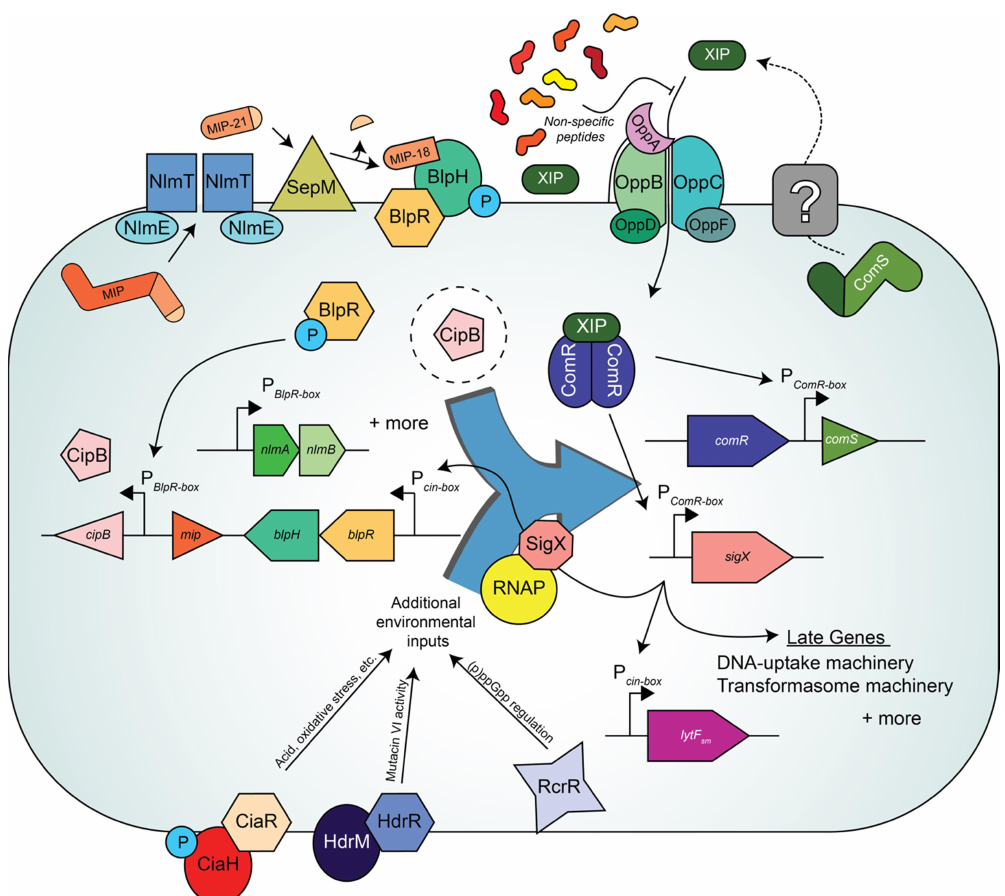
Figure 2. The ComRS quorum sensing (QS) pathway controls competence, and the BlpRH QS system regulates bacteriocin production in S. mutans strain UA159. The ComS pre-peptide is exported and processed via an unknown mechanism (denoted as a dotted line and gray box) into XIP. In a chemically defined, peptide-poor medium (CDM) XIP is re-imported via oligopeptide permease (Opp) and binds ComR. The ComR/XIP complex binds upstream of comS and sigX at P ComR -box sites [31]. The alternative sigma factor, SigX, facilitates RNA polymerase (RNAP) binding at P cin-box sites [64]. Genes regulated by SigX include the DNA-uptake and transformasome machinery as well as the murein hydrolase, LytF sm , among others [59,68]. Non-specific peptides present in high concentrations in peptide-rich media are thought to prevent intracellular transport of XIP via Opp [69]. Recently, a link between the bacteriocin and competence pathways was determined to be mediated by SigX at a P cin-box site upstream of blpRH (formerly referred to as comDE , see Table 1). The BlpRH QS pathway pheromone, MIP, is exported and processed by the ABC transporter complex NlmTE into the 21 amino-acid long precursor peptide, MIP-21 [27]. Cleavage of MIP-21 by the protease SepM results in fully active MIP-18 [11]. MIP-18 is thought to bind to BlpH, resulting in activation and phosphorylation of BlpR similarly to CSP binding and activation of ComDE in S. pneumoniae [13]. BlpR~P binds at P BlpR-box sites upstream of bacteriocin loci such as cipB and nlmAB , among others [70]. Although the mechanism is unknown (represented by the dotted circle surrounding CipB), the activity of CipB is required for the indirect induction of SigX observed when cells are grown in peptide-rich media and treated with MIP [22,71,25]. Multiple other regulatory pathways are observed to feed into the ComRS/BlpRH QS networks, such as the CiaHR, HdrRM, and the RcrRPQ systems [72-77]. These additional inputs along with possible contribution through the BlpRH-regulated QS pathway (i.e., via cipB expression [71]) may help S. mutans to integrate environmental cues into the competence signaling cascade, allowing for fine tune control of natural transformation (depicted by the blue block arrow).